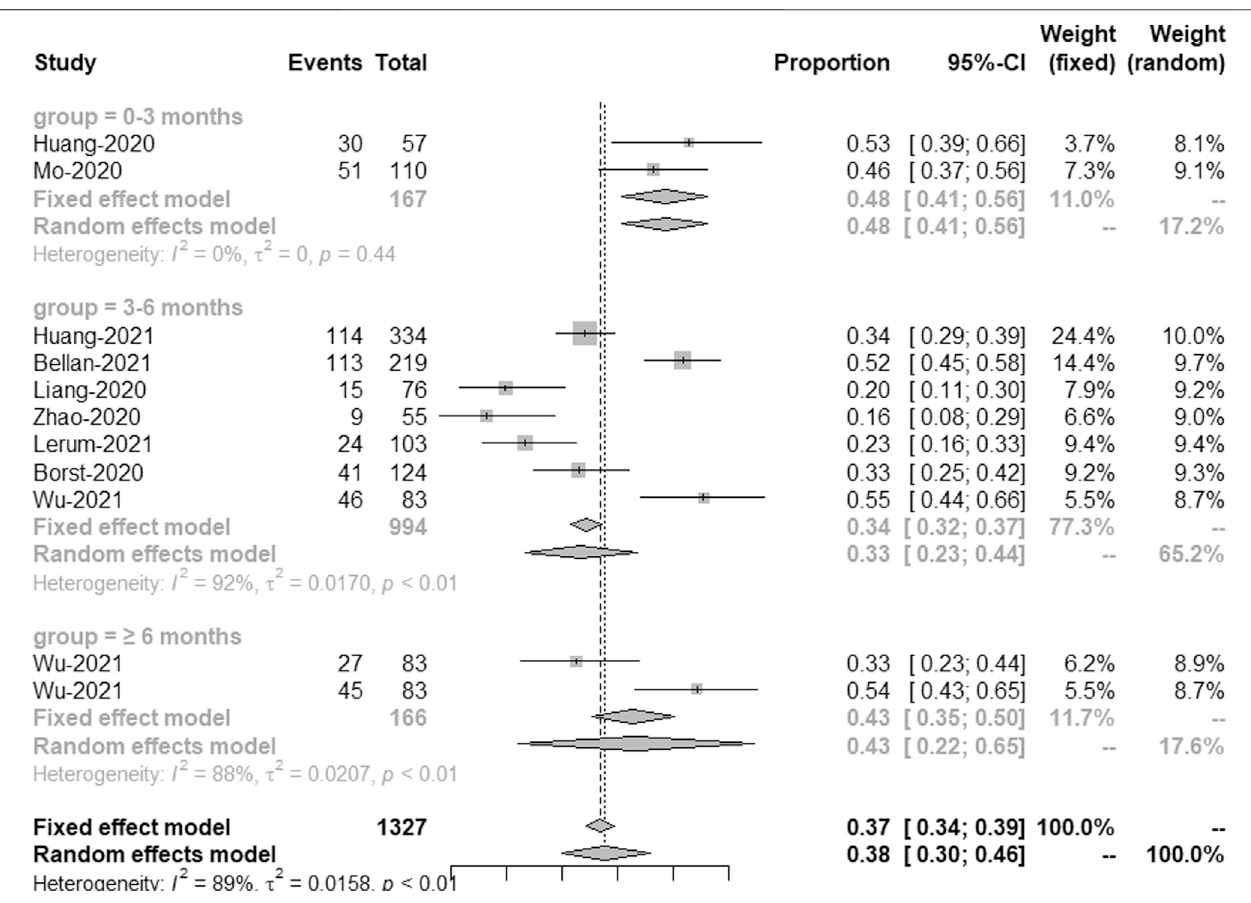
FIGURE6| Comparison oflongitudinalchangesinthepercentage ofpatientswithDLCO < 80%ofpredicted.Forestplotshowingmeta-analysis ofthepercentage of patients with DLCO < 80% of predicted.